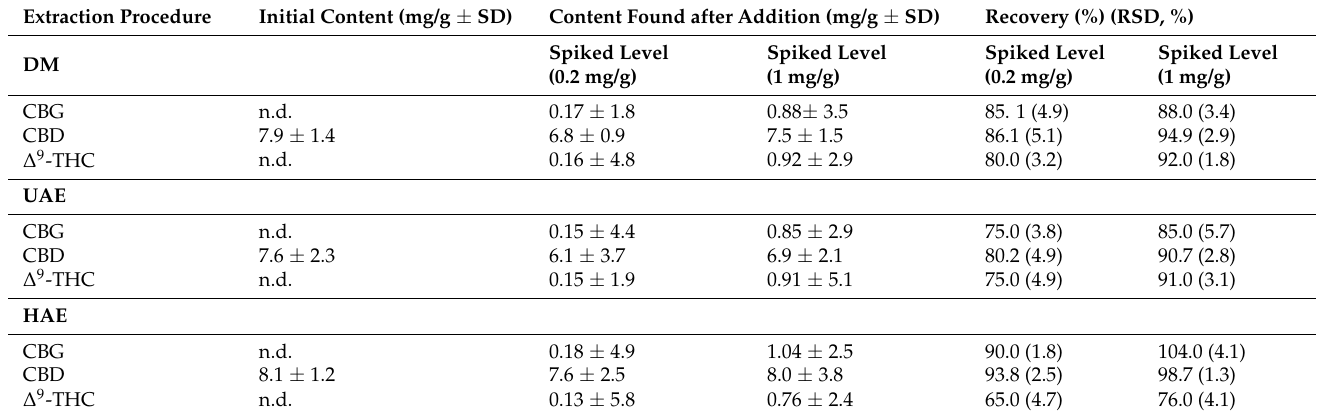
Table 3. Mean recovery data with the three extraction